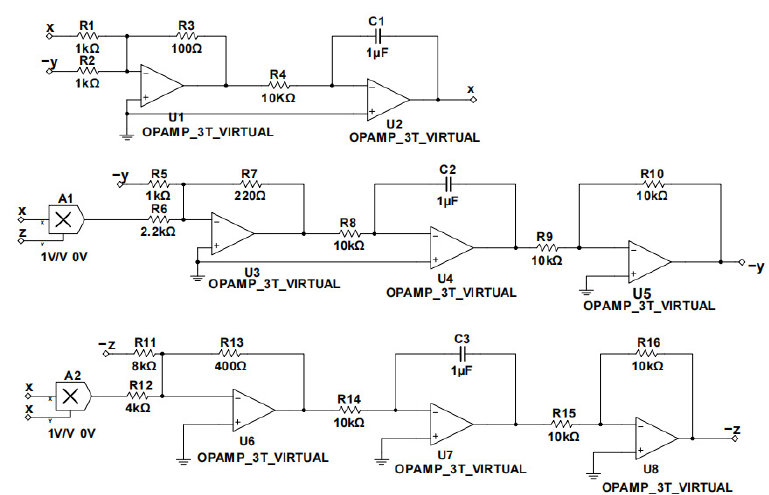
Figure 1. Circuit implementation diagram of Bao chaotic